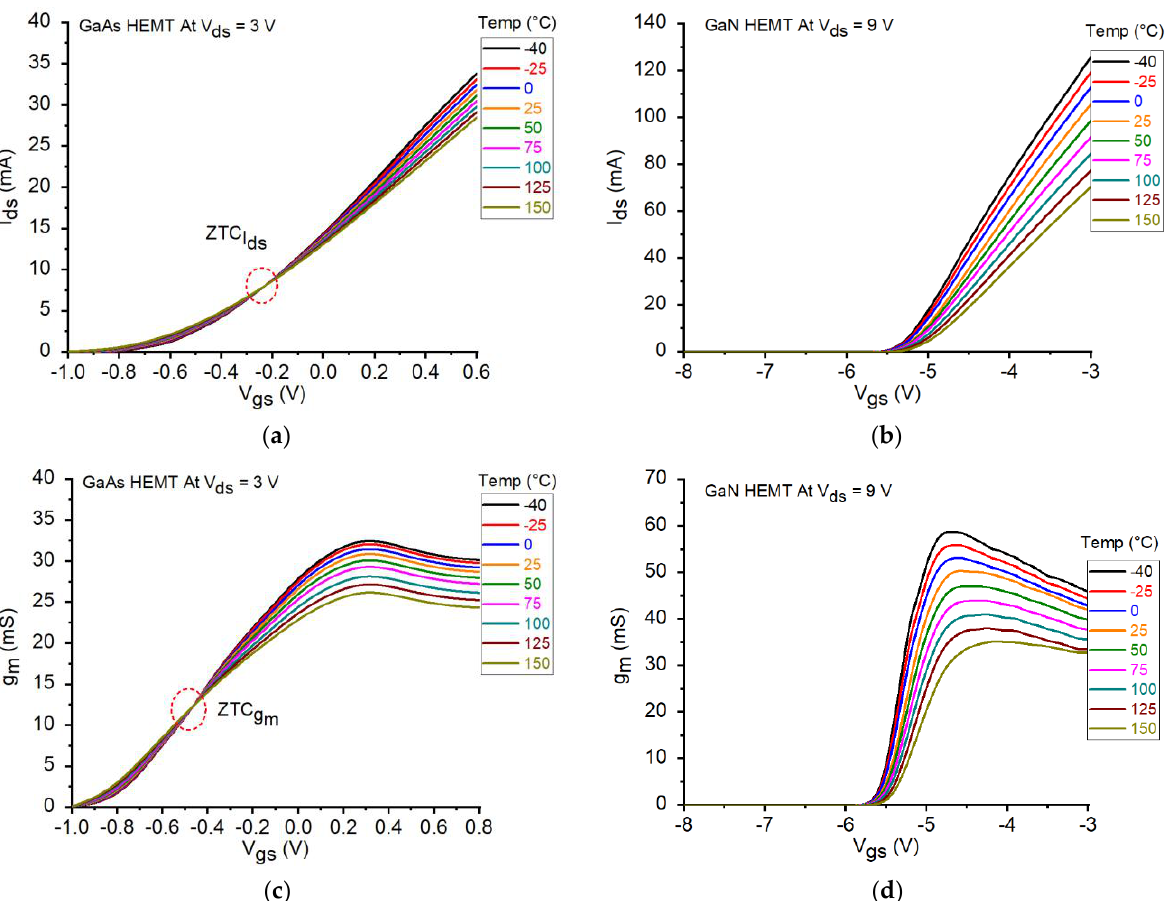
Figure 5. DC transcharacteristics and transconductances at different T a for ( a , c ) the GaAs HEMT at V ds = 3 V and ( b , d ) the GaN HEMT at V ds = 9 V.